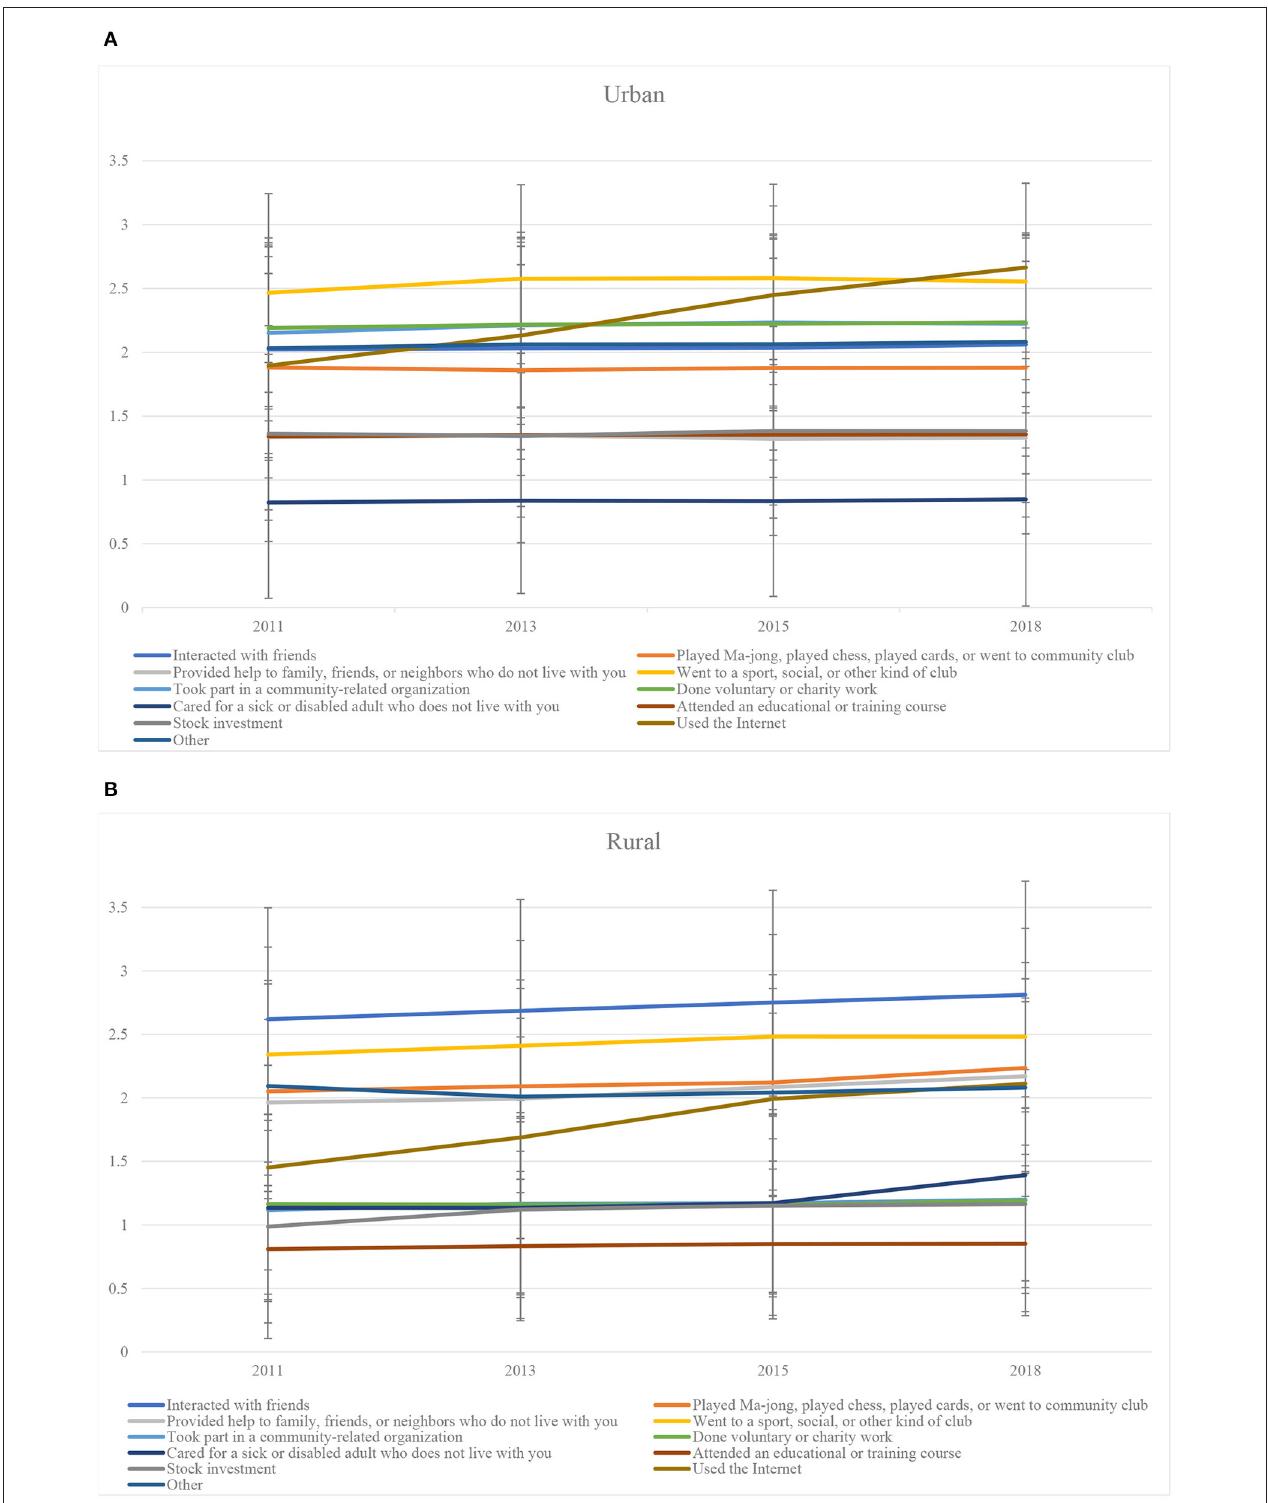
FIGURE 1 | Distribution of social engagement